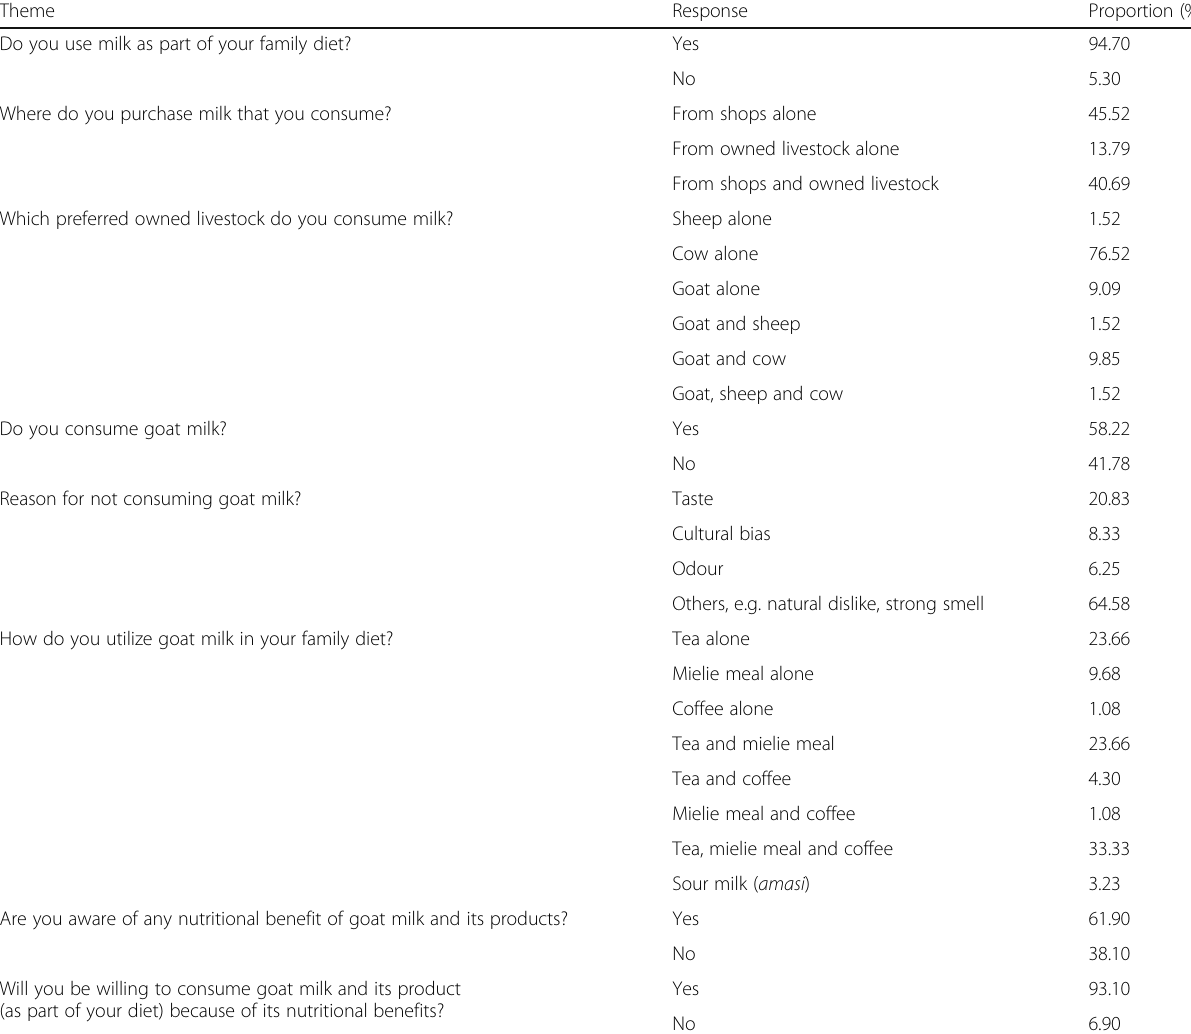
Table 2 Descriptive features of households response to questions regarding their perceptions and willingness to consuming goat milk